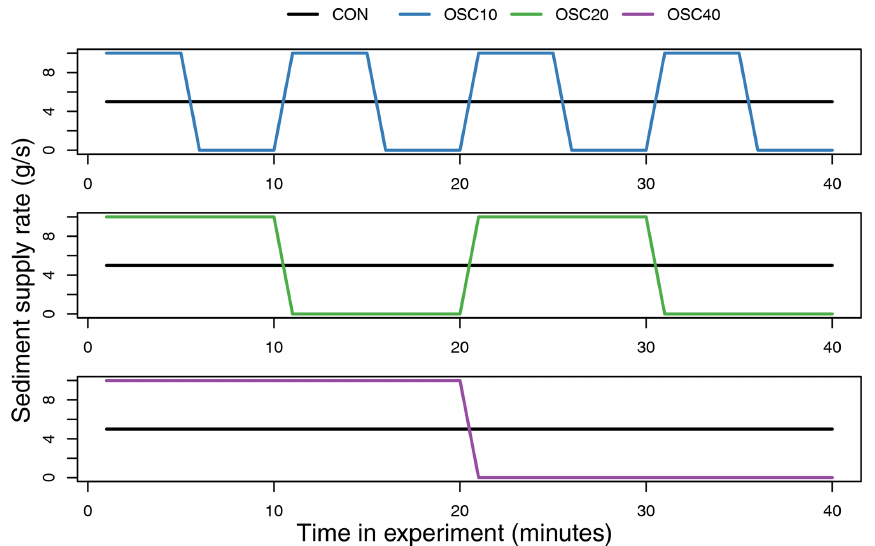
Figure 2. The durations of high-supply and zero-supply periods in Runs CON and OSC10–OSC40. The constant sediment supply rate in Run CON equals the mean supply rate in all other